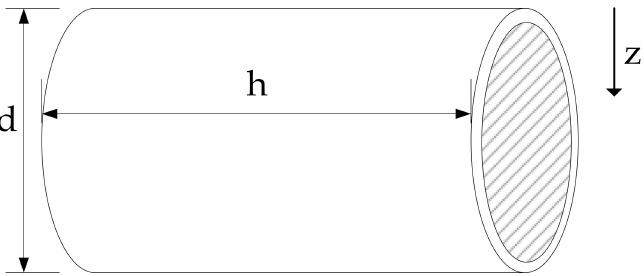
Figure 5. Schematic representation of the chromatographic monolith with diameter (d), height (h) and flow direction (z) of the